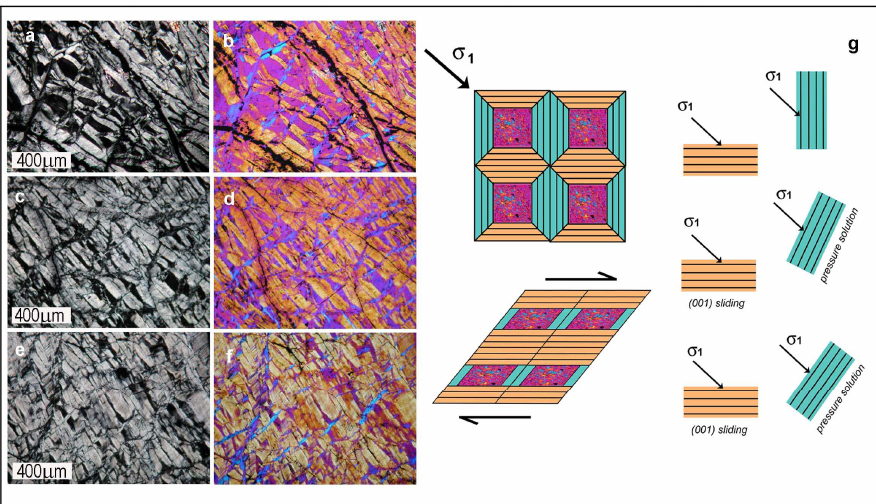
Figure 5. Progressive deformation of mesh textures: ( a , c , e ) polarised-light images (crossed nicols) showing progressive deformation of mesh textures until the cores disappear; ( b , d , f ) corresponding images with the retardation gypsum plate; and ( g ) cartoon showing stress response in four mesh cells. The cartoon shows the orientation of σ 1 with respect to (001) liz in rims. It is worth noting that, during shear deformation, the angle between σ 1 and (001) liz of blue rims progressively increases, whereas it remains constant in the case of yellow rims.